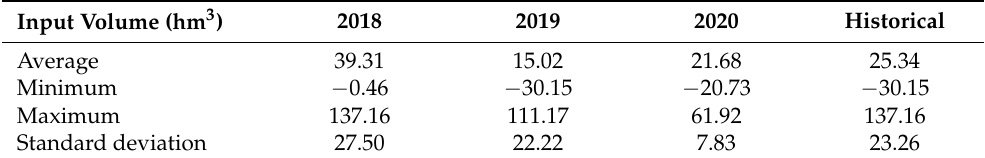
Table 5. Input daily volumes to the dam reservoir (hm 3 per day).